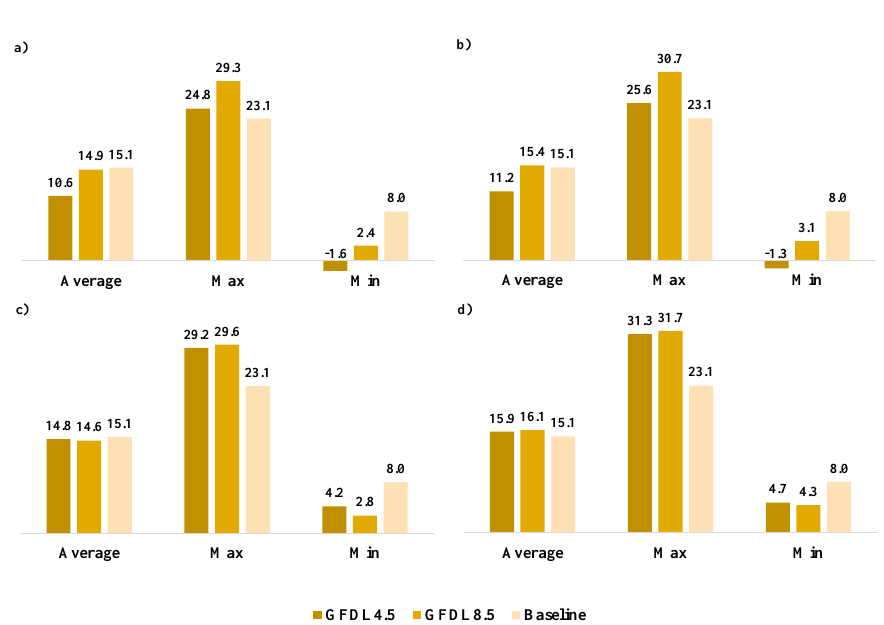
Figure 3. The annual average precipitation (mm) for the baseline conditions and climate scenarios: ( a ) timeline 2030; ( b ) timeline 2060. For clarification on the modelled scenarios, please see Figure 2.